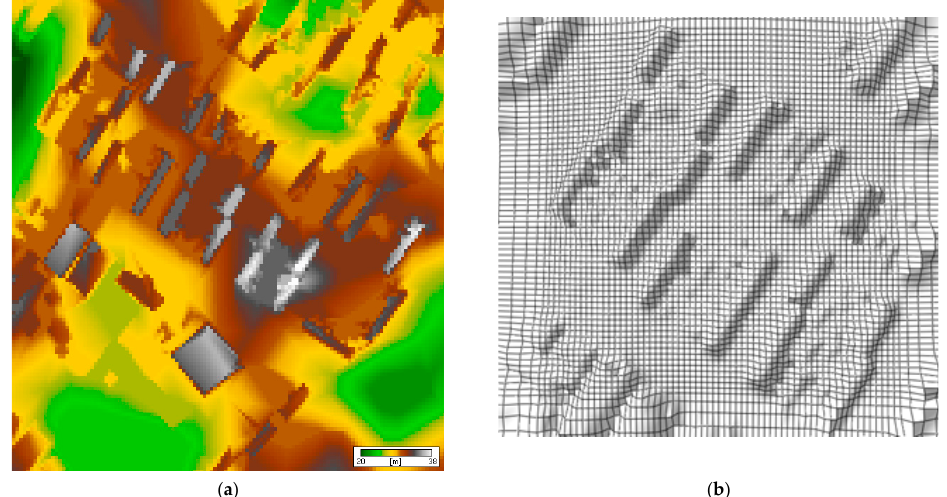
Figure 13. ( a )—Digital urban terrain model at 0.5 m × 0.5 m spatial resolution computed by WAsP Engineering; ( b ) Regular nested mesh generated by WindSim model for the central urban area with 2 m × 2 m spatial resolution.